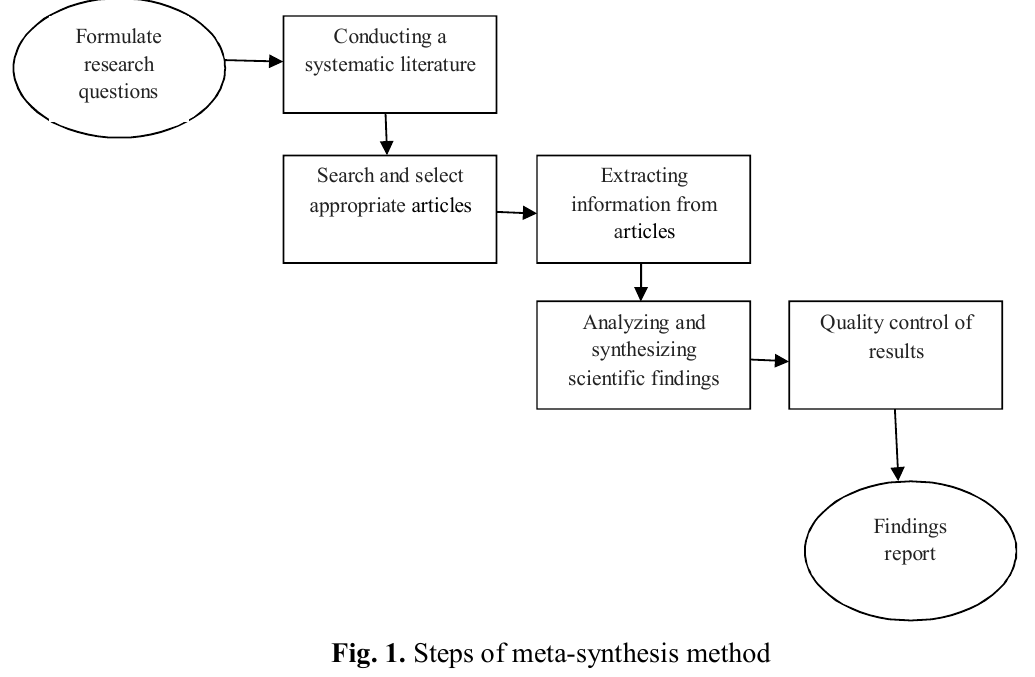
Fig. 1. Steps of meta-synthesis